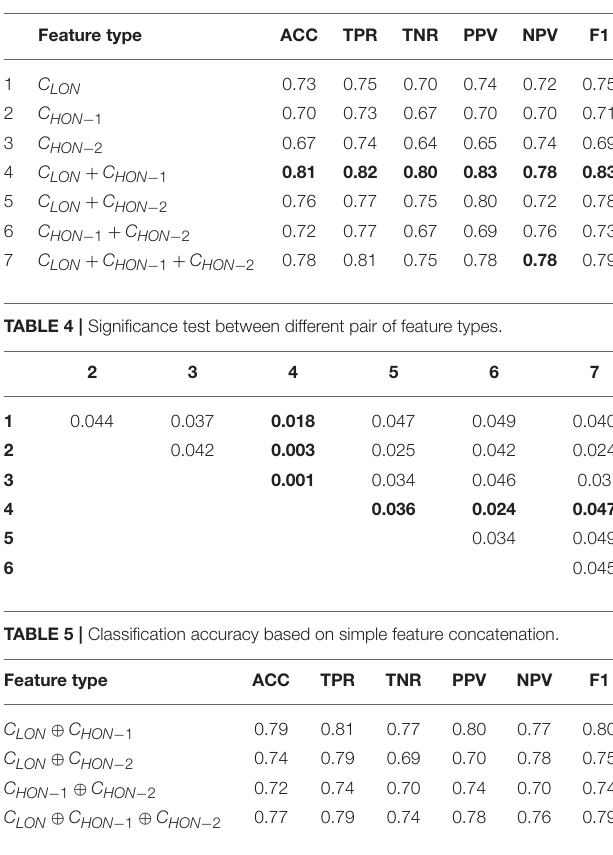
TABLE 3 | ASD classification using different feature types.